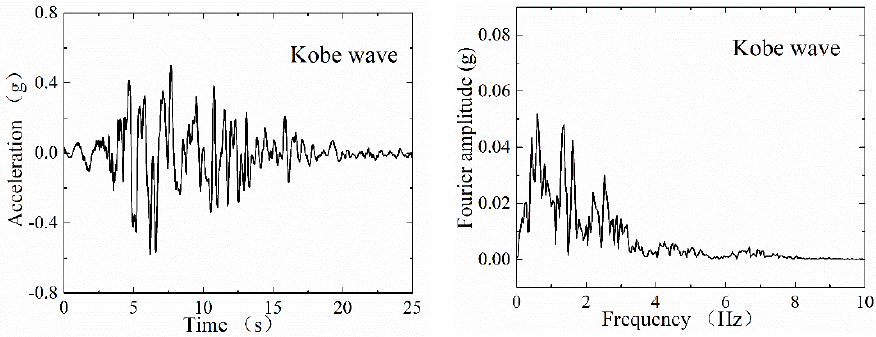
Figure 5. Input earthquake motions.